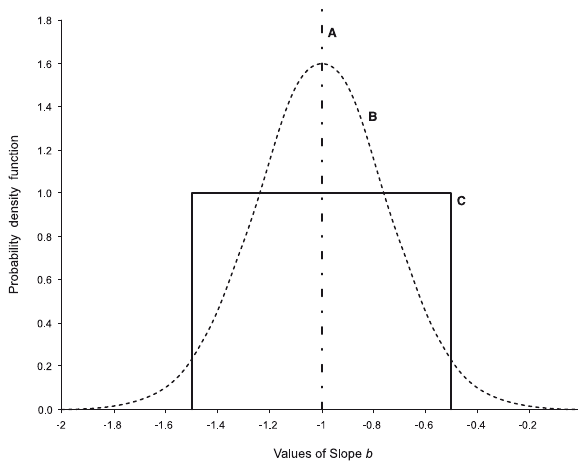
F ig . 1. – Three ways to generate the theoretical value of b of the system to be sampled. The coefficient b for Monte Carlo simulation was fixed at –1 (A) or was randomly chosen from a normal distribu- tion with mean=–1 and s.d.= 0.25 (B) or from a uniform distribution between –1.5 and –0.5 (C).